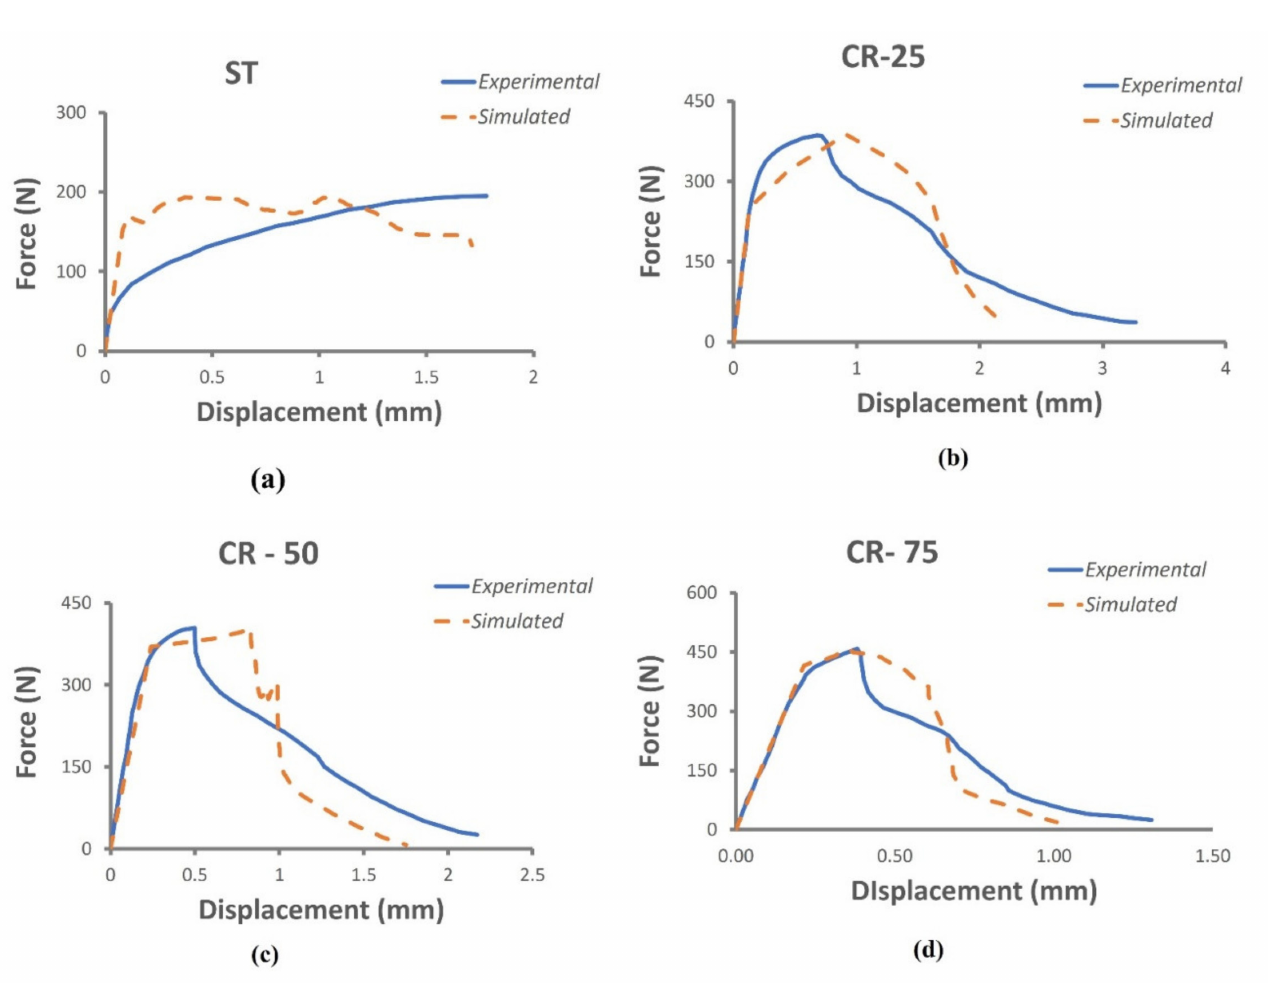
Figure 10. Comparison of experimental and simulated results in a three-point bend test specimen ( a ) ST ( b ) CR-25 ( c ) CR-50 ( d ) CR-75. Table 4. Mesh sensitivity analysis of three-point bend test simulation for ST